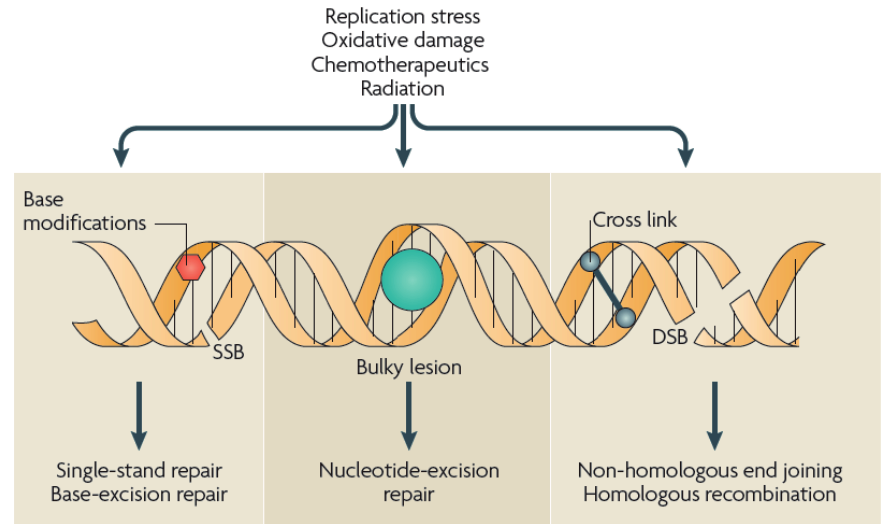
Figure 11. Types of DNA damage and repair. Various types of DNA damage can occur in cells as a result of endogenous agents, such as replication stress or free radicals from oxidative metabolism, and exogenous agents, such as ionizing or UV radiation and chemotherapeutics. These agents can cause SSBs or DSBs in the DNA, base modifications, helix-distorting bulky lesions or cross-links of DNA strands that are repaired by biochemically distinct DNA repair pathways. Adapted from [132] with permission from Macmillan Publishers, Ltd.,